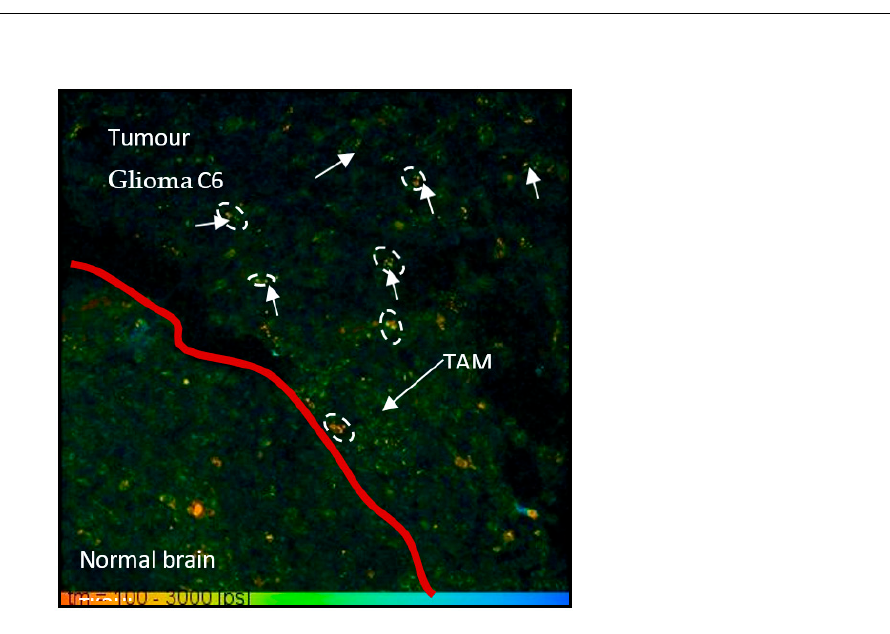
Figure 6. FLIM image characterising the fluorescence lifetime distribution of exogenous fluorophores in brain tissue at the border of C6 glioma tumour and normal tissue.